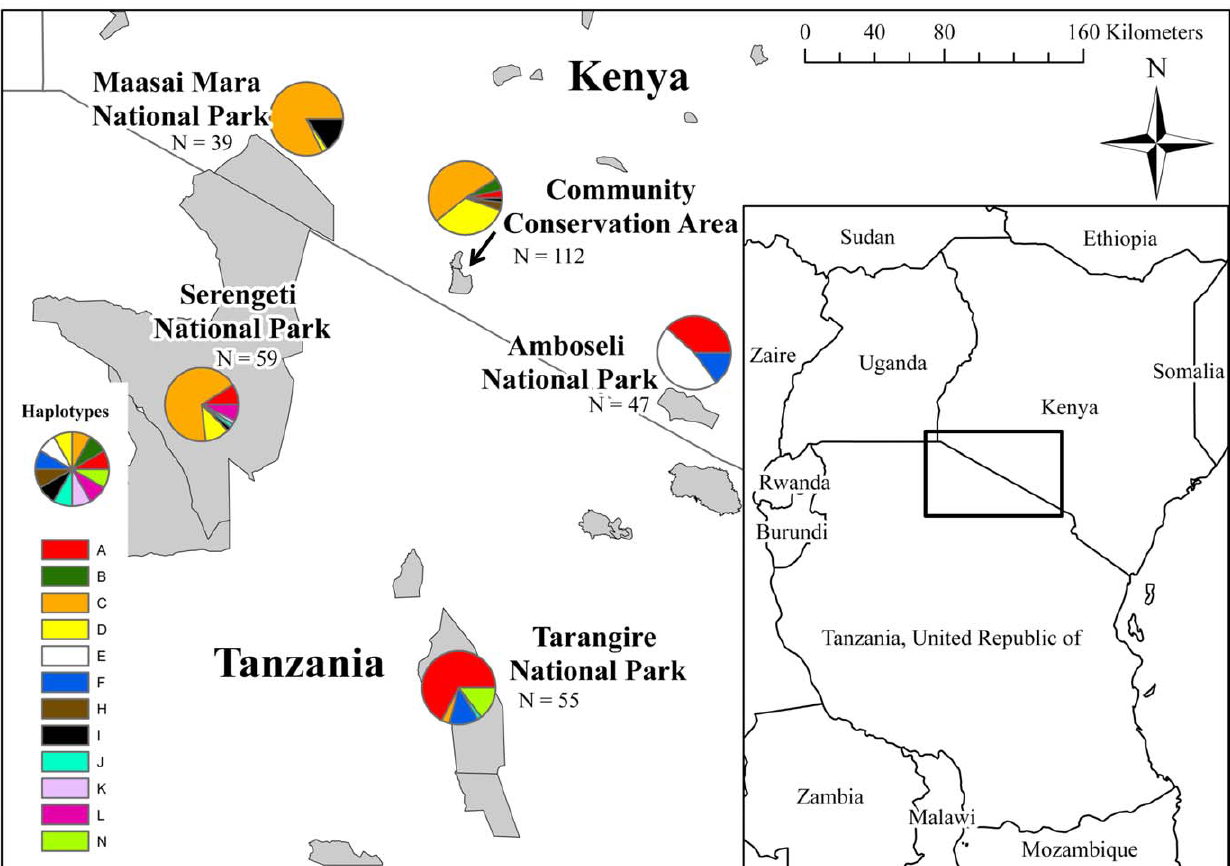
Figure 1. Map of Sampling Locations. Map of the sampling locations in southern Kenya and northern Tanzania, including the sample size of individuals and mtDNA haplotype frequencies for each site; the Rift Valley splits the study area, Maasai Mara and Serengeti are on the west side of the valley, Amboseli and Tarangire are on the east side of the valley, while the CCA is located within the Rift Valley.